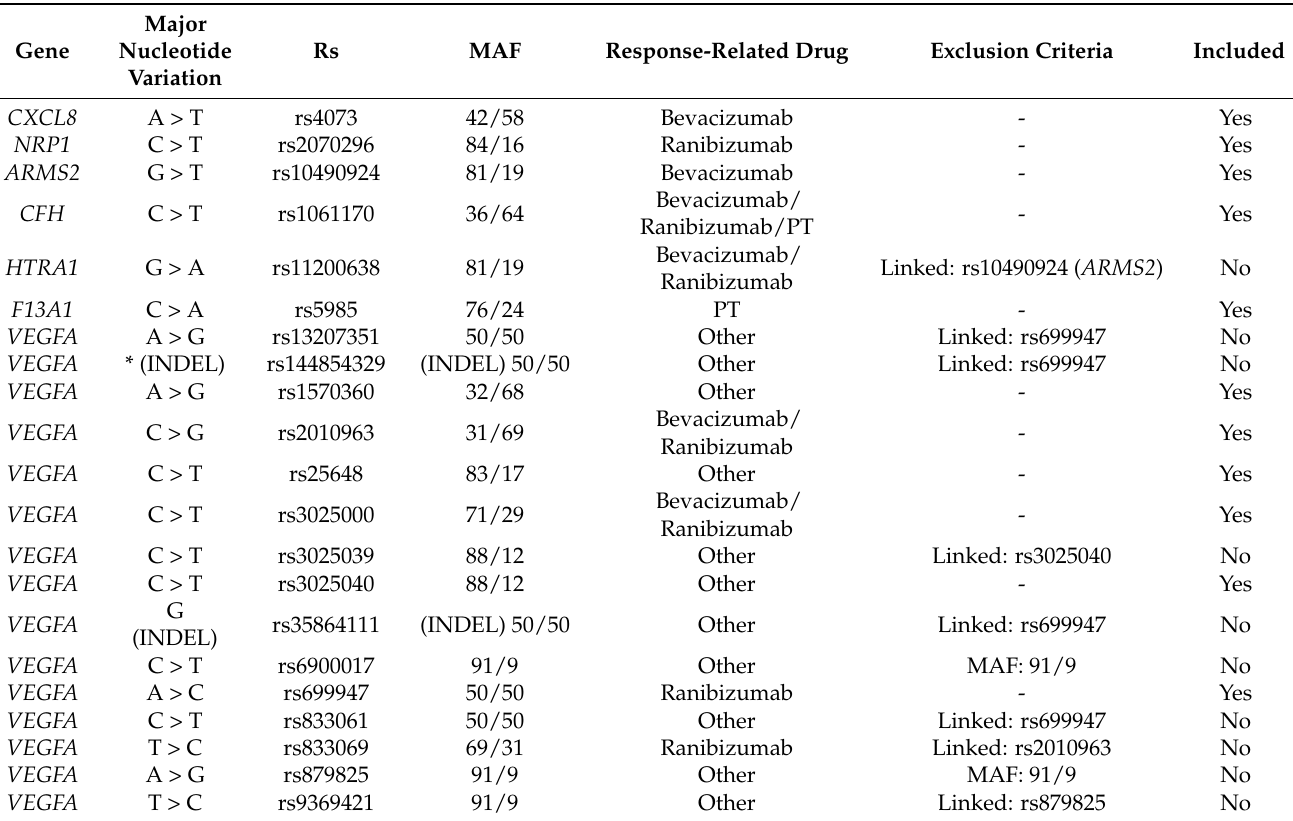
Table 1. Genetic polymorphisms considered for